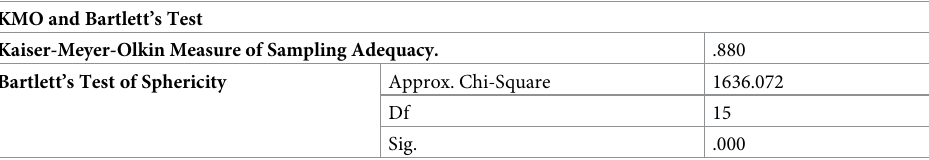
Table 7. Kaiser-Meyer-Olkin Measure of Amharic LMUP.